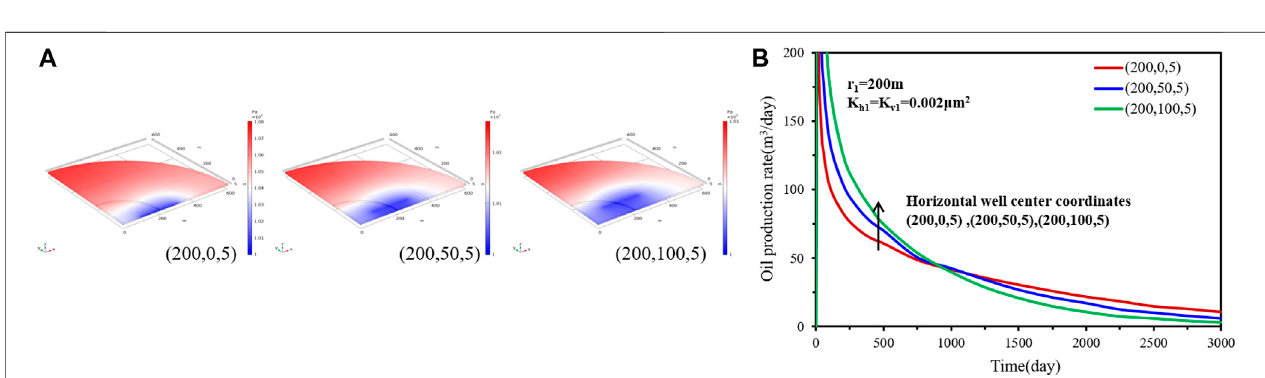
FIGURE 12 | Effect of horizontal well position on (A) transient pressure and (B) rate decline performance.